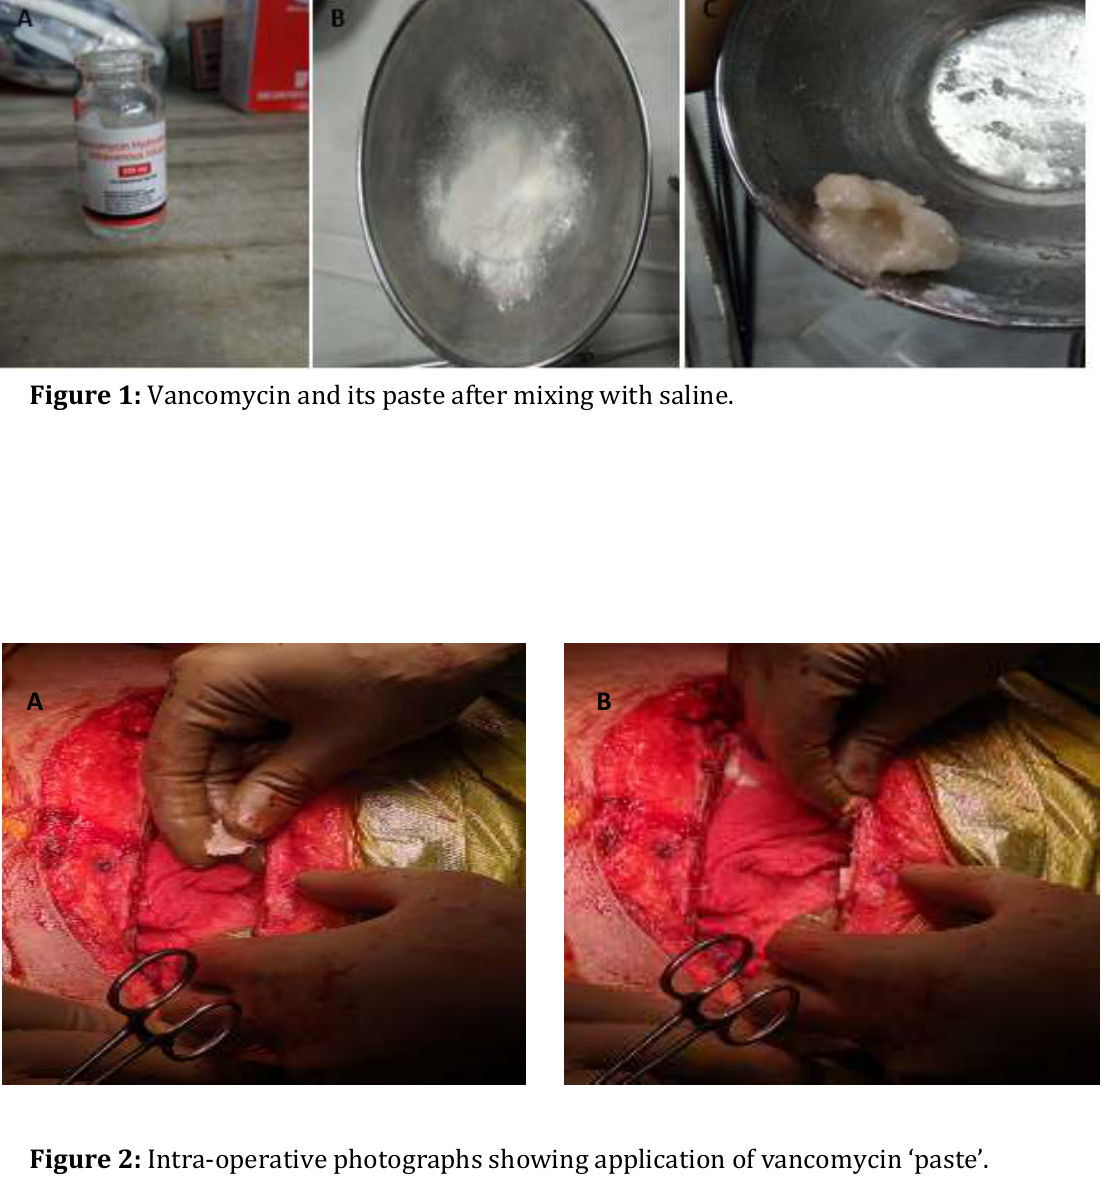
Figure 2: Intra-operative photographs showing application of vancomycin ‘paste’.